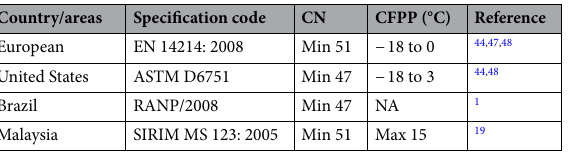
Construction of calibration curves for cell density measurement. Cell density calibration curves were constructed using absorbance reading at OD 681, which was the optimum absorption wavelength for M. gracile using a micro plates reader Varioskan™ LUX (Thermo Fisher Scientific, USA). The number of cells mL -1